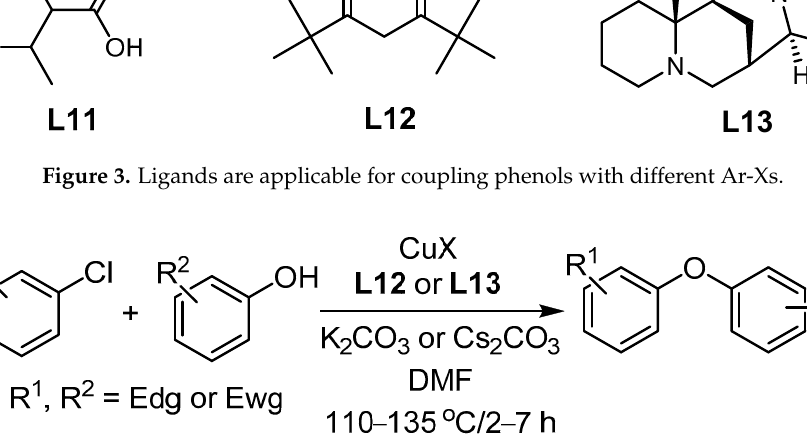
Scheme 29. (Nano)copper catalysts-based coupling of aryl chlorides with phenols [109–112].